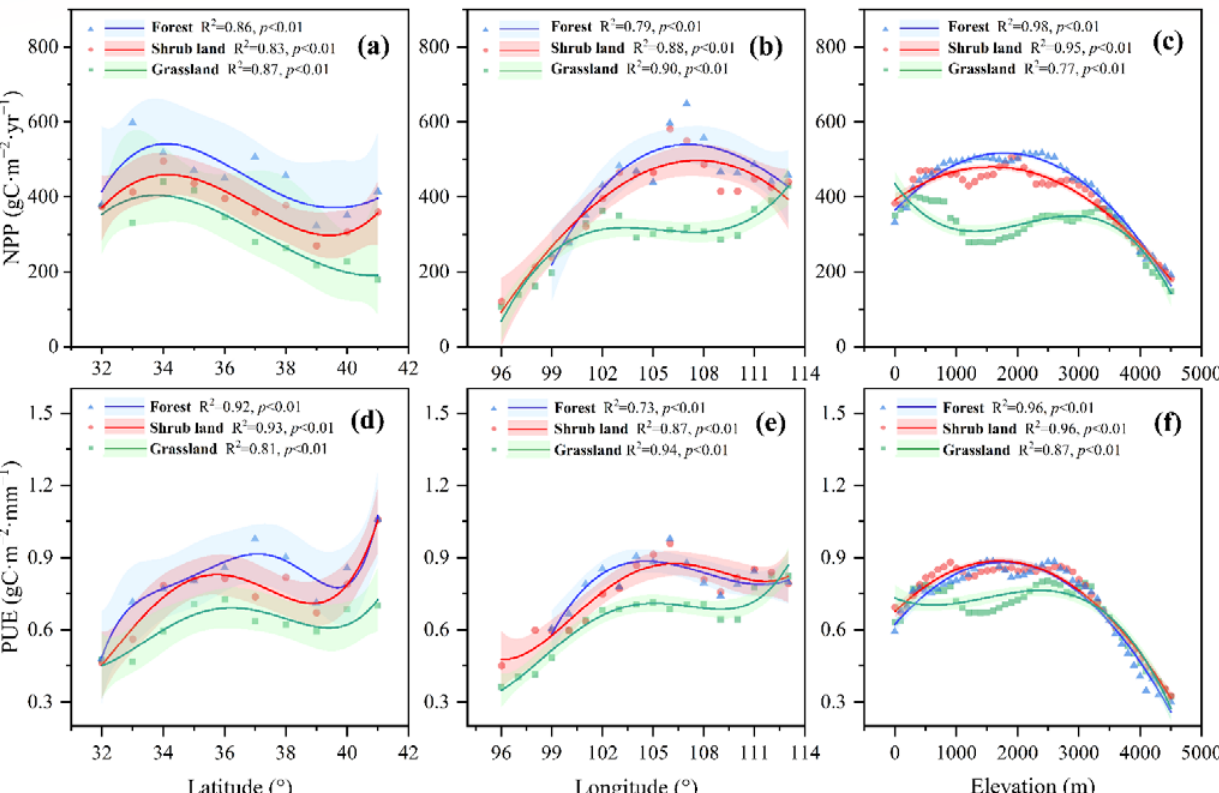
Figure 4. Variations in NPP and PUE across latitude ( a , d ), longitude ( b , e ), and elevation ( c , f ) gradient of forest, shrub land and grassland in the YRB. Soild lines are the regression curves, and shading represented the regression analysis confidence range (5th and 95th percentiles). Each point is the bin-averaged value at 1° latitude intervals in ( a , d ), 1° longitude intervals in ( b , e ) and 100 m elevation intervals in ( c , f ).